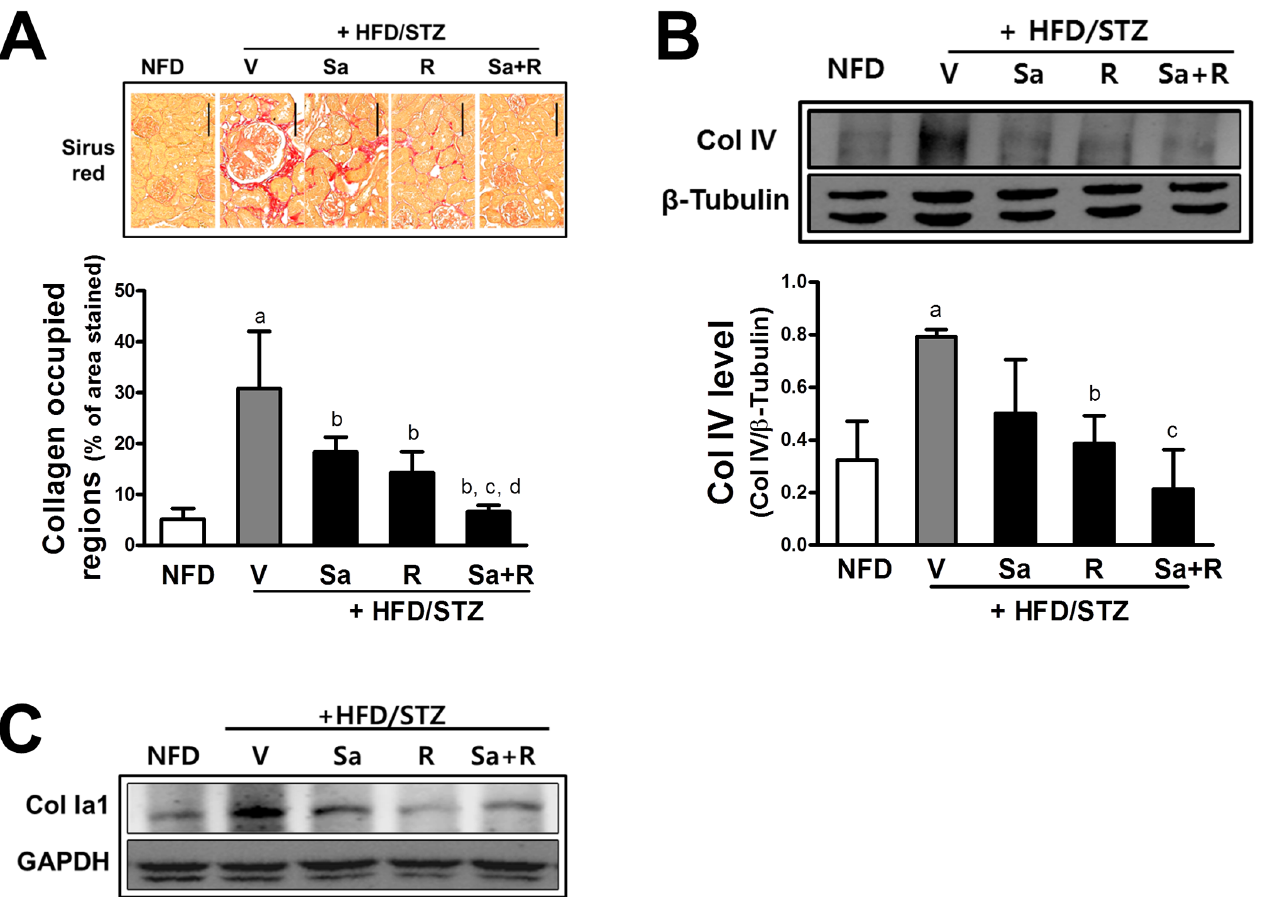
Fig 5. Attenuation of collagen deposition by sarpogrelate and rosuvastatin. (A) Kidney tissues were stained with Sirius red and cortex areas with collagen deposition were quantified. Two histological fields for each kidney tissue were analyzed. All data represent means ± SD. Scale bar = 120 μ m (B) Protein levels of collagen type IV in kidney homogenates were assessed with western blot analysis. Data are means ± SD from three determinants of pooled samples. a P < 0.05 compared with the NFD control group. b P < 0.05 compared with the HFD/STZ group. c P < 0.05 compared with the HFD/STZ +Sa group. d P < 0.05 compared with the HFD/STZ + R group. (C) Protein levels of renal collagen type Ia1 were monitored with western blot analysis. Similar blots were obtained from three independent